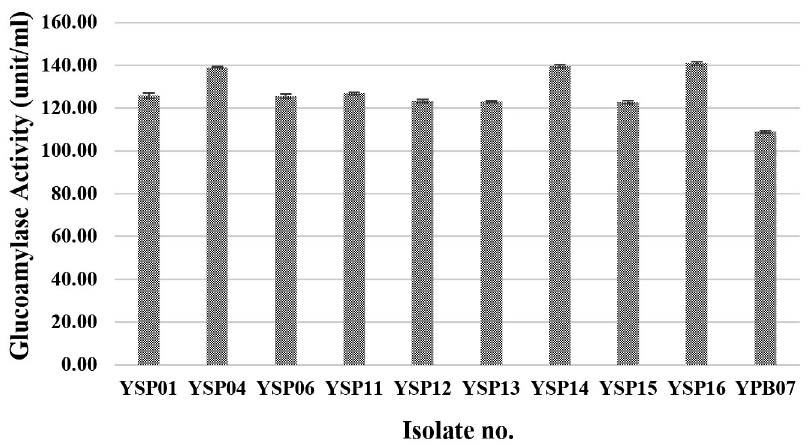
Fig.2.(A). Glucoamylase activities of fungi were isolated from Loog-pang-khao-mak ; (A) Glucoamylase activities of ten yeast isolates